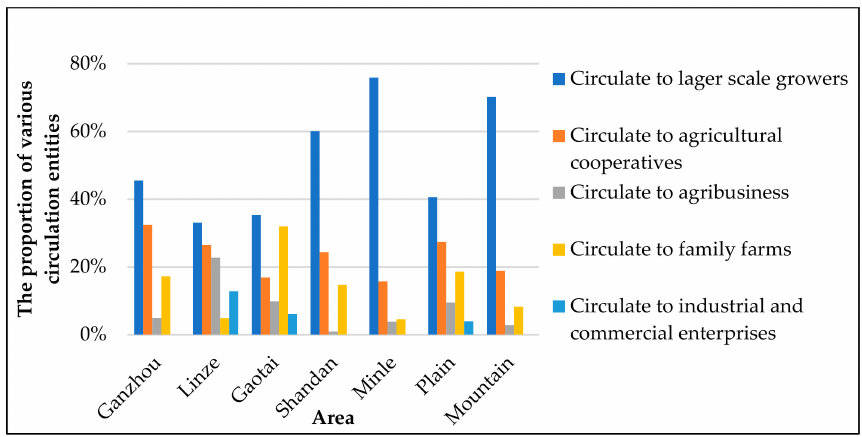
Figure 4. Proportion of farmland circulation directions in various districts of Zhangye City.